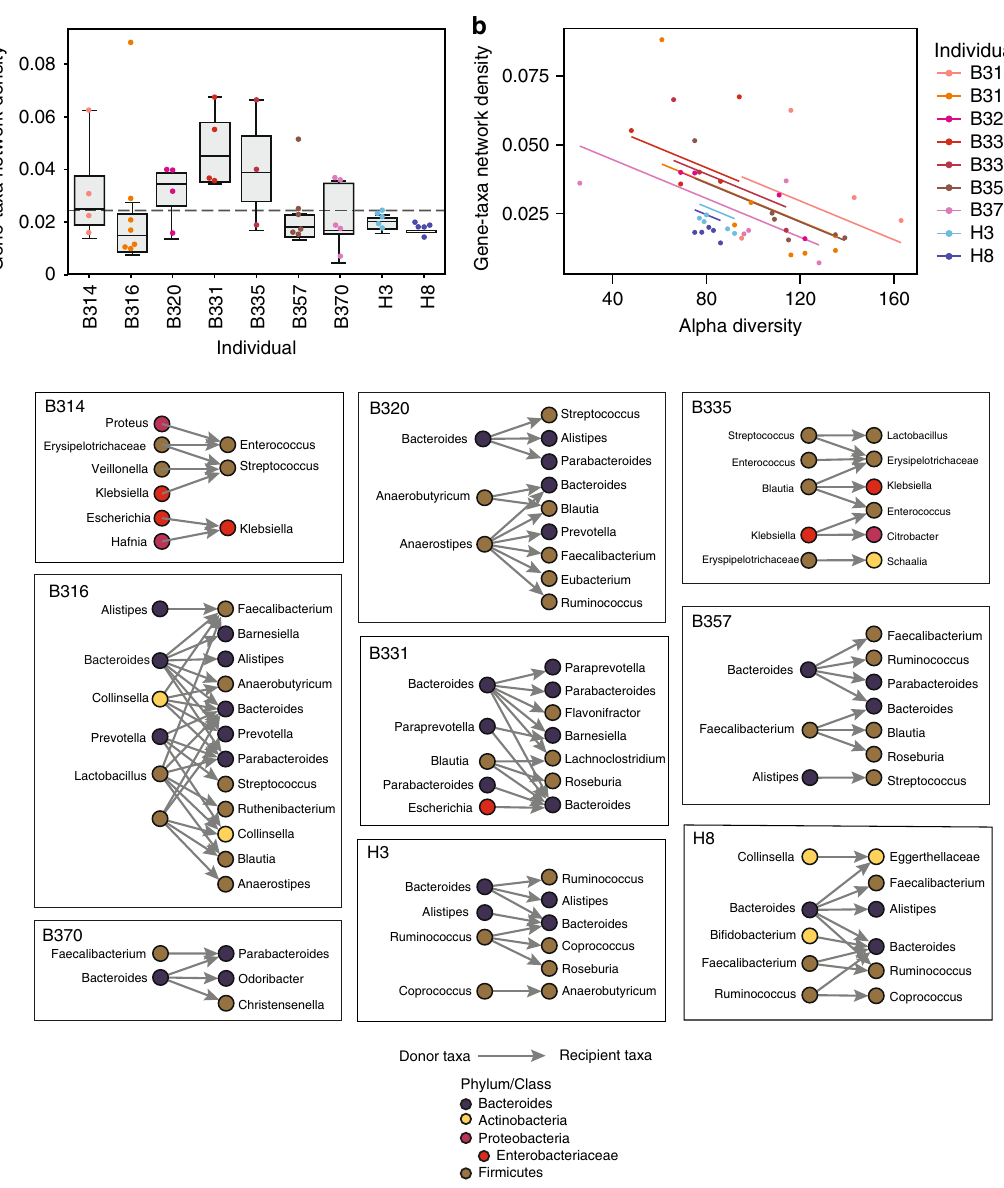
Fig. 3 HGT is frequent and results in the emergence of bacteria carrying novel AR genes. a Boxplots showing the gene – taxa network linkage densities, or the proportion of total possible gene – taxa links that are observed to be linked, for each individuals ’ samples ( n = 4, 7, 4, 4, 3, 6, 5, and 5 for B314, B316, B320, B331, B335, B357, B370, H3, H8, respectively). A dotted line is shown at the maximum network density observed in the healthy samples. The bounds of the box represent the fi rst and third quartiles with the center line as the median value. The ends of the whiskers represent either the smallest and largest values or at most ±1.5 × interquartile range. b Individual patient samples are plotted according to the alpha diversity, assessed using Metaphlan, and their gene – taxa network density. An ANOVA showed that gene – taxa network density was related to alpha diversity ( F (1,39), p = 3.3 × 10 − 5 ) and health status ( F (1,6), p = 0.01501). c All observed HGT events across different genera are plotted for each individual. Each genus is colored according to its